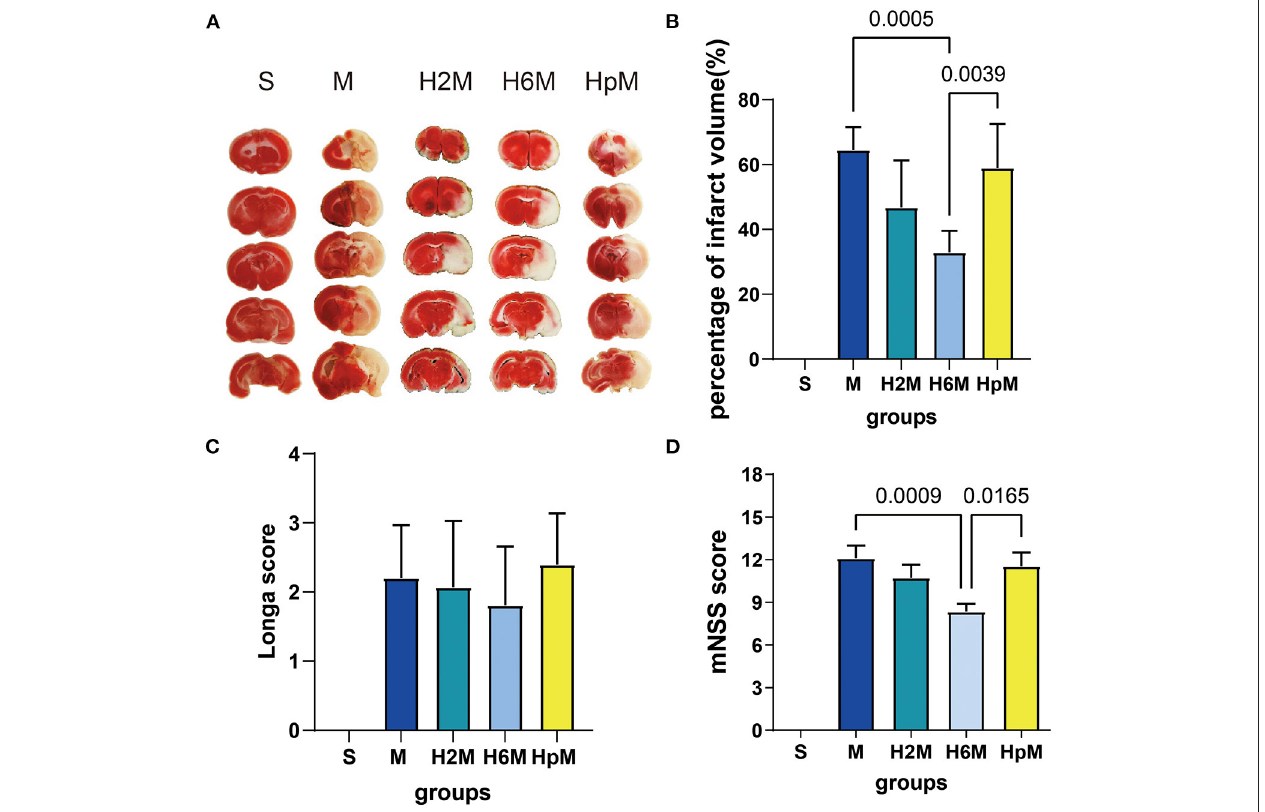
FIGURE 2 | Effects of HHP on cerebral MCAO-induced ischemia. (A) 2,3,5-Triphenyl tetrazolium chloride (TTC) staining of the whole brain tissue. (B) Cerebral infarct volume calculation with edema correction 24h after stroke. One-way ANOVA showed differences among the five groups, F = 33.89, p < 0.0001. Results are presented as mean ± SD ( n = 5). (C) Longa score assessment 24h after occlusion. One-way ANOVA showed differences among the five groups, F = 33.00, p < 0.0001. Results are presented as mean ± SD. S group ( n = 20), M group ( n = 20), H2M group ( n = 15), H6M group ( n = 26), HpM group ( n = 15). (D) modified Neurological Severity Scores (mNSS) assessment 24h after occlusion. One-way ANOVA showed differences among the five groups, F = 50.21, p < 0.0001. Results are presented as mean ± SD. S group ( n = 20), M group ( n = 20), H2M group ( n = 15), H6M group ( n = 26), HpM group ( n = 15). ANOVA, analysis of variance; HHP,